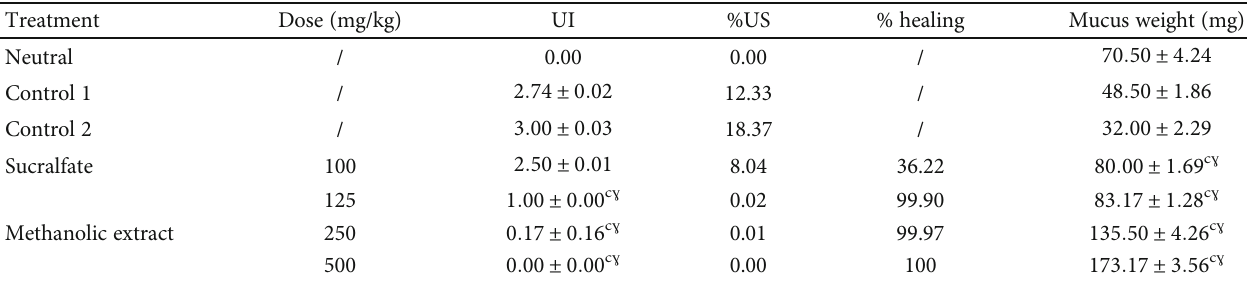
Each value represents the mean ± standarderror of the mean of 6 animals and analyses by one-way ANOVA followed by Tukey post hoc test; c p < 0 : 001 : signi fi cant when compared to negative control 1 (ulcerated rats killed 5-day postethanol administration); ɣ p < 0 : 001 : signi fi cant when compared to negative control 2 (received indomethacin for 4 days + 3% DMSO for 10 days). UI: ulcer index; US: ulcerated